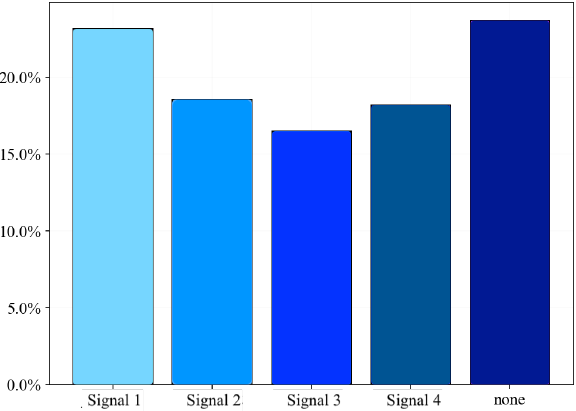
Figure 16. Example distribution of data from a single